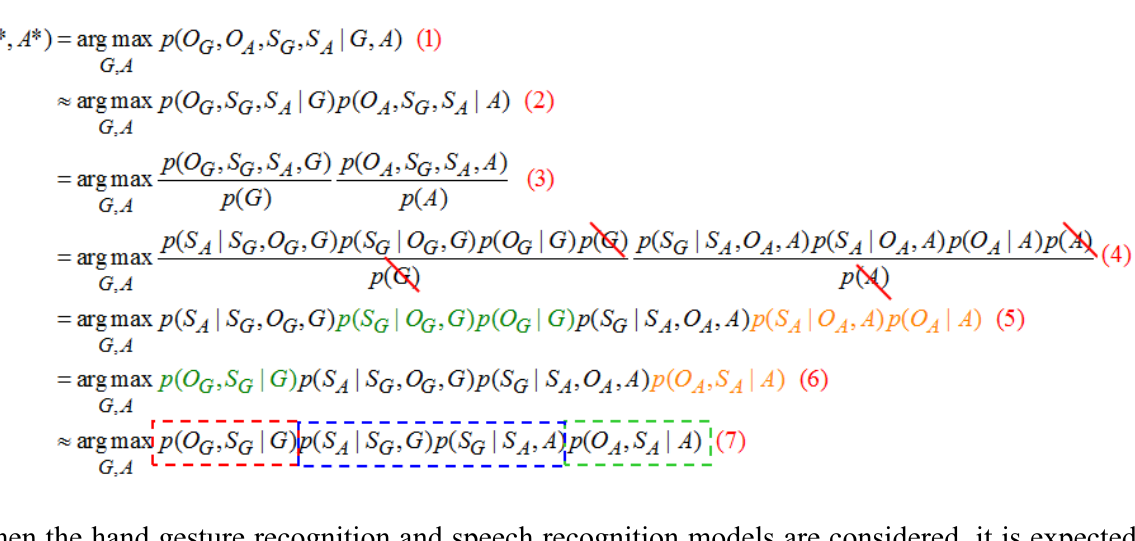
Figure 17. Gesture and speech recognition model adopted Bayesian